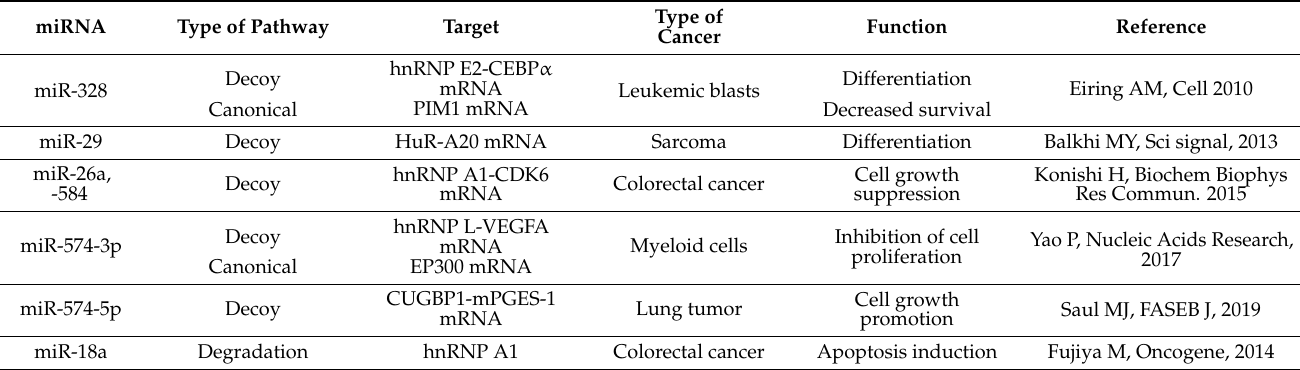
Table 1. Protein-targeted miRNAs and regulation